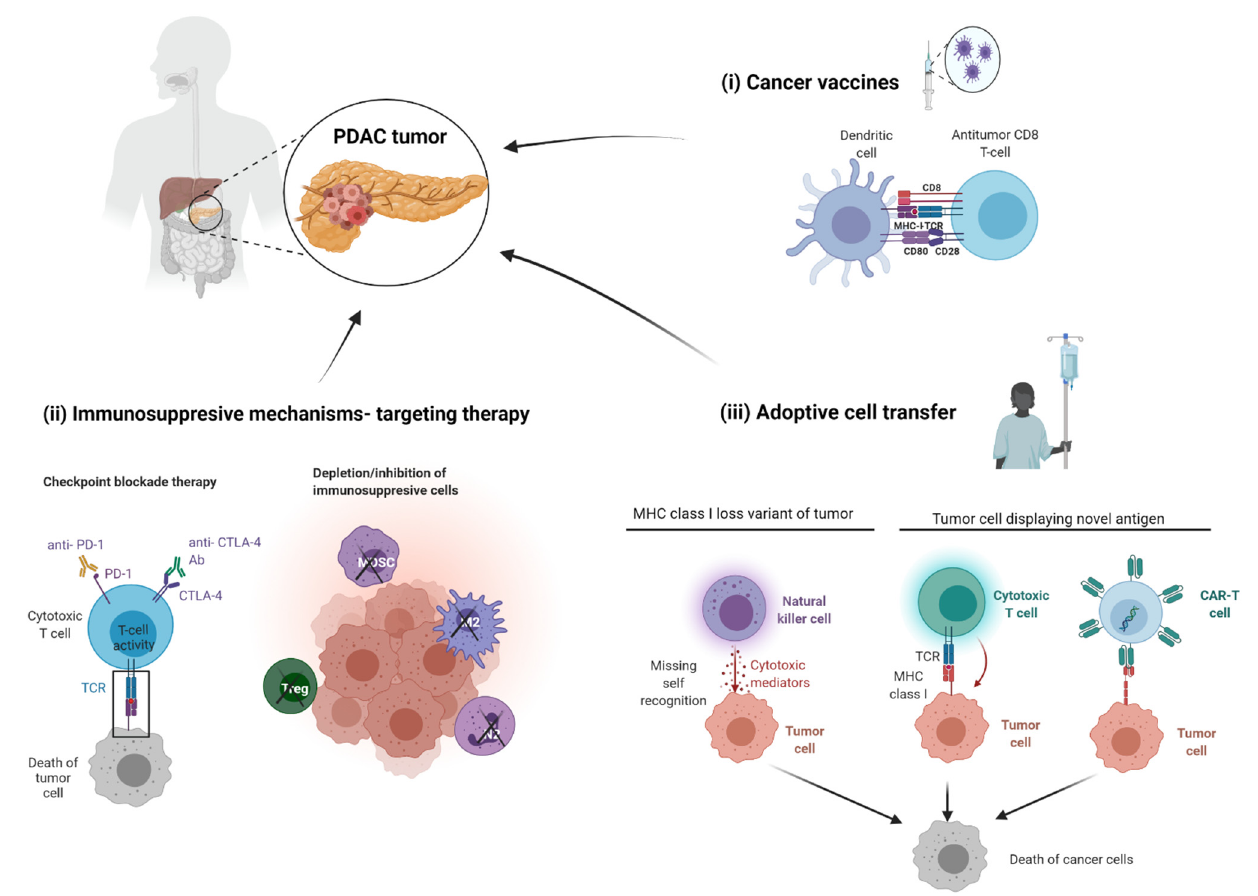
Figure 3. Immunotherapies to treat PDAC. There are several proposed strategies to target immunological aspects of PDAC which are ( i ) cancer vaccines, ( ii ) targeting immunosuppressive mechanism by immune checkpoint blockage therapy, and ( iii ) adoptive cell transfer which are comprised of NK, Cytotoxic lymphocyte, and CAR-T therapies. PDAC = pancreatic ductal adenocarcinoma, PD-1 = programmed cell death protein 1, CTLA-4 = cytotoxic T lymphocyte associated protein 4, TCR = T cell receptor, Treg = regulatory T cell, MDSC = myeloid derived suppressor cell, M2 = Tumor associated M2 macrophage, N2 = tumor associated N1 neutrophil, MHC = major histocompatibility complex, CAR = chimeric antigen receptor. Figure made in BioRender.